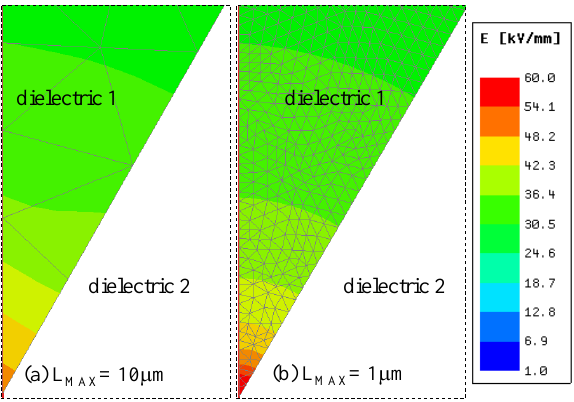
Figure 3: Electric field ( E ) at the “dielectric 1” side of the mesh surface region of the DUT shown in Figure 2; super- imposed is the numerical mesh: (a) mesh with L MAX =10 µ m, (b) mesh with L MAX = 1 µ m. The colormap legend ranges from 1 kV/mm to 60 kV/mm.